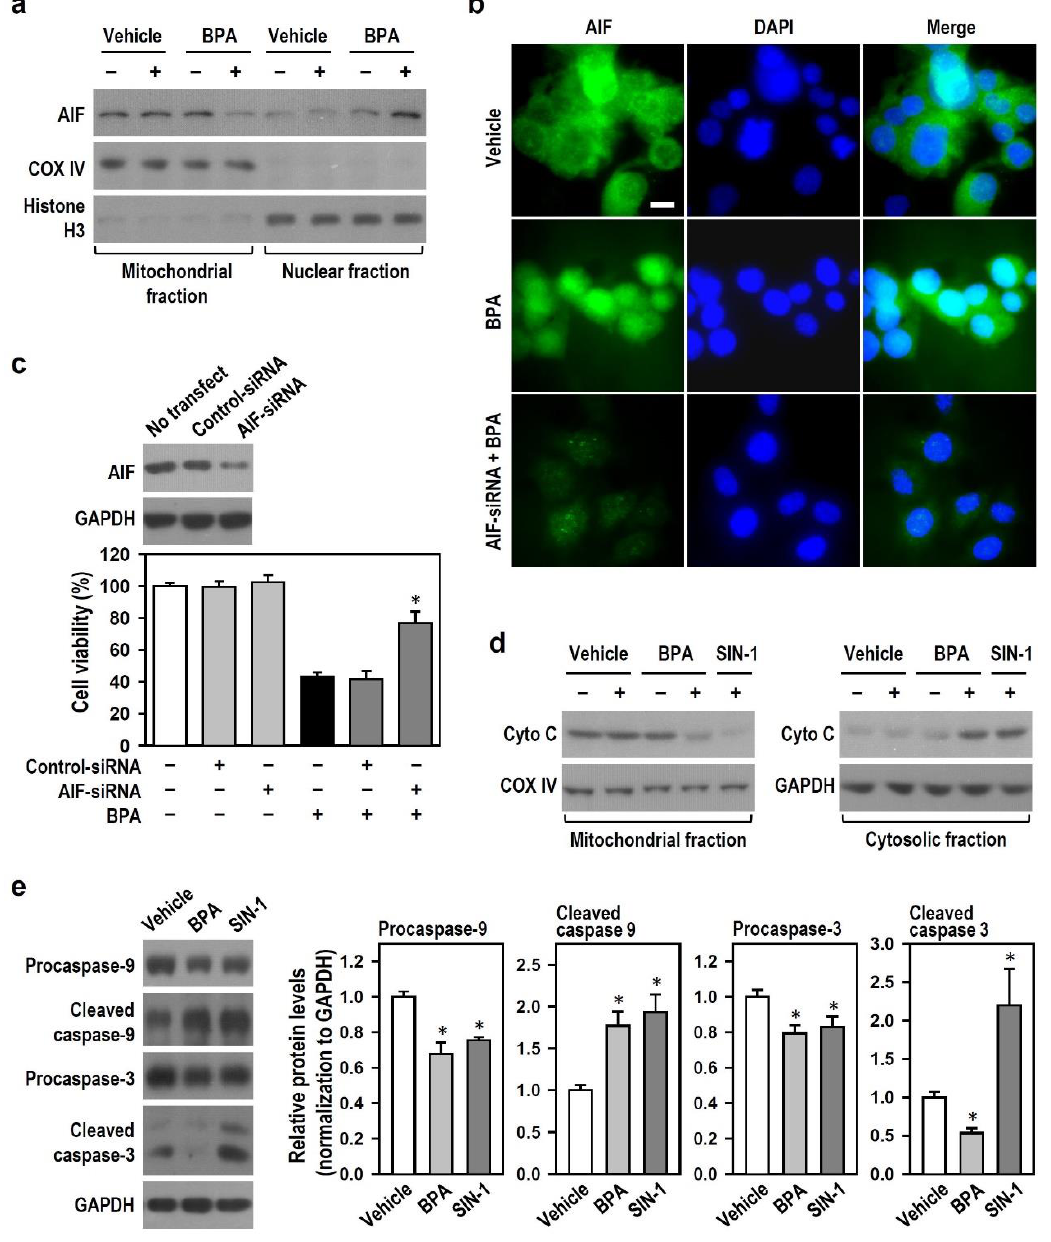
Figure 4. BPA impairs the cytochrome c/caspase-9/caspase-3 apoptotic axis and elicits a nuclear translocation of mitochondrial apoptosis-inducing factor (AIF) in N2a cells. ( a ) Cultures treated with vehicle or 100 μM BPA for 12 h were harvested and subjected to subcellular fractionation. AIF level was detected by Western blots. Cytochrome c oxidase (COX) IV and histone H3 were the markers of mitochondrial and nuclear subcellular fractions, respectively. ( b ) Repre- sentative fluorescence images of AIF immunoreactivity (green) are shown (scale bar = 10 μm). Cells grown on coverslips were harvested 12 h after vehicle or 100 μM BPA treatment. DAPI staining (Nucleus, dark blue) allows identification of the nuclear translocation of AIF (Merge, light blue). ( c ) Transient transfection of small interfering RNA (siRNA) was used to silence AIF protein formation. Cultures were untreated or treated with control- or AIF-siRNA (50 nM) as indicated, and the silencing efficacy was evaluated by Western blots. Additionally, the siRNA-transfected cultures were exposed or not to BPA for 24 h. Cell viability was assessed by MTT reduction assay. The bar plot shows the survival percent compared to the untreated control group (assigned a value of 100%). Values are represented as mean SEM ( n = 4, triplicate). * p < 0.05 vs. BPA alone. ( d ) Similar manipulation was conducted as ( a ), and cytochrome c level was detected by Western blots. COX IV and GAPDH were mitochondrial and cytoplasmic markers, respectively. 3-morpholinosyndomine (SIN-1) at 1 mM was a positive control to induce apoptosis. ( e ) Cultures exposing to vehicle or the indicated agents for 24 h were harvested and subjected to Western blots to detect procaspase-9, cleaved caspase-9, procaspase-3, and cleaved caspase-3